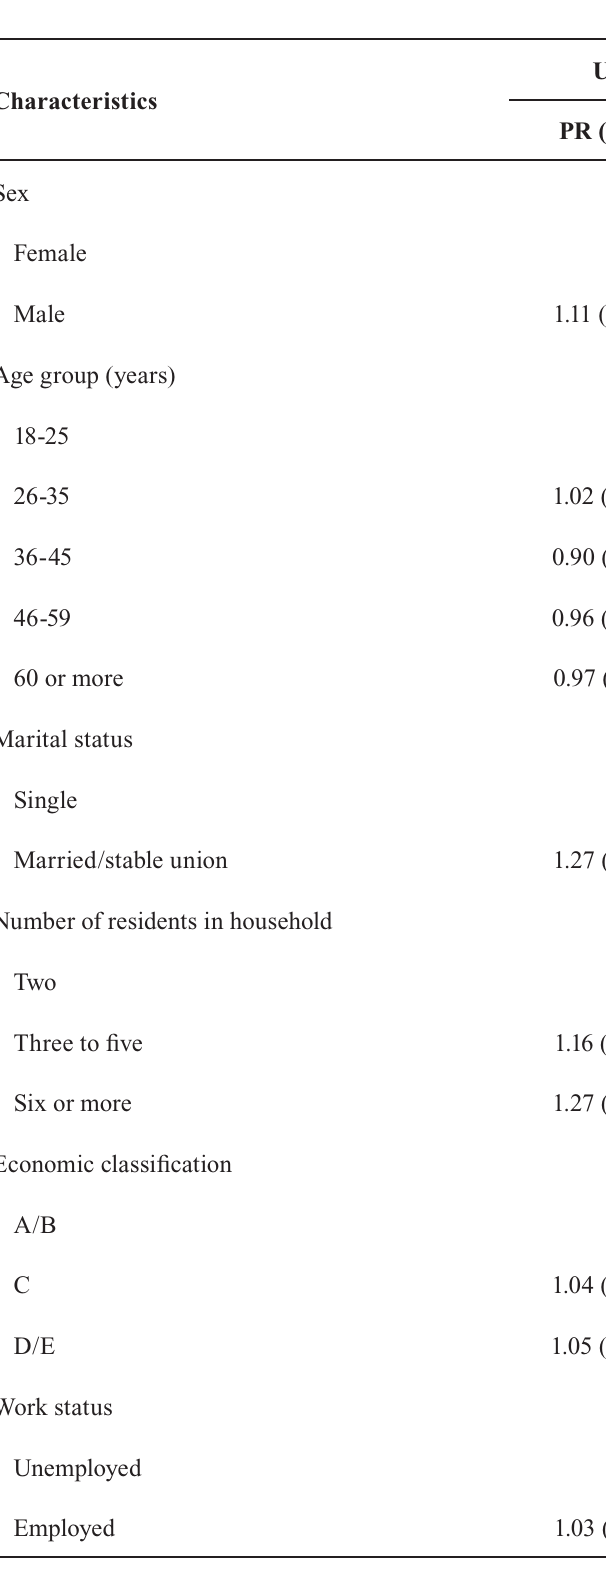
TABLE IV - Prevalence ratio (PR) of use of medicines in the 15 days prior to data collection (95% CI), Manaus Metropolitan Region,